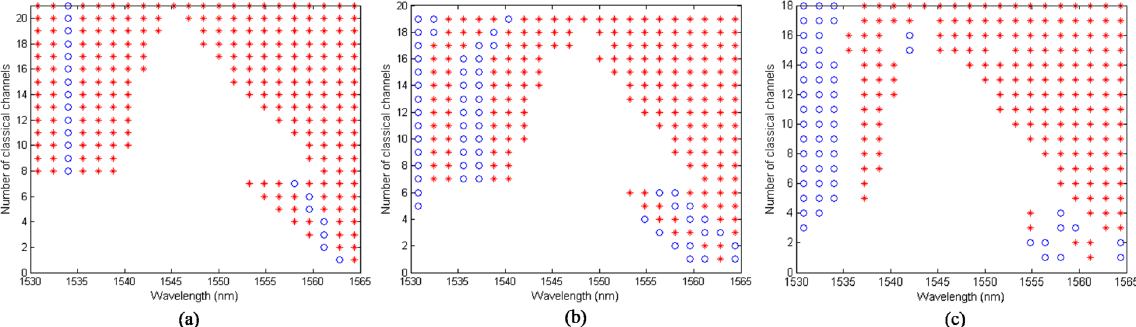
Figure 6. Proposed wavelength assignment patterns in a 200 GHz full-duplex system in ( a ) “Raman noise only” case for M = 1, ( b ) “Raman noise only” case for M = 3, and ( c ) “Raman + Adjacent channel crosstalk” case for M = 3 at L = 50 km. Each row depicts the optimum location of quantum and classical channels in the wavelength grid, where (red) * represents a classical channel and (blue) ° represents a quantum one.